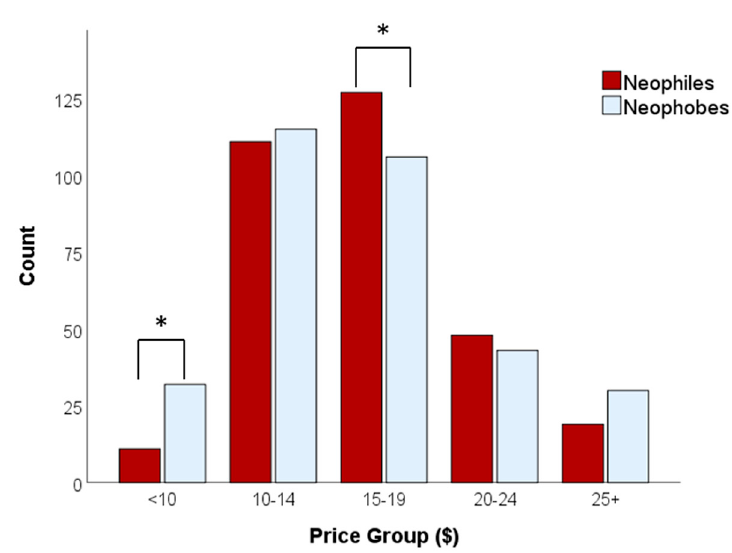
Figure 3. Results of chi-square analysis showing the number of neophiles (red) and neophobes (blue) as a function of average price paid per 750 mL bottle of wine. Asterisk (*) denotes a significant difference between groups.